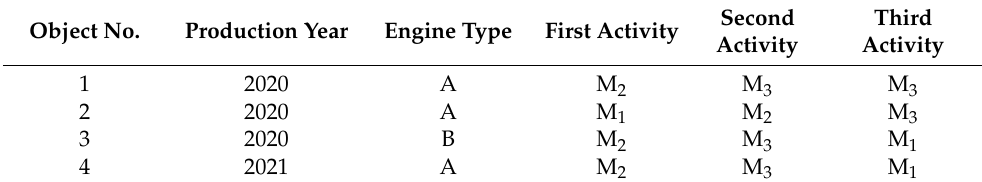
Table 3. Testing